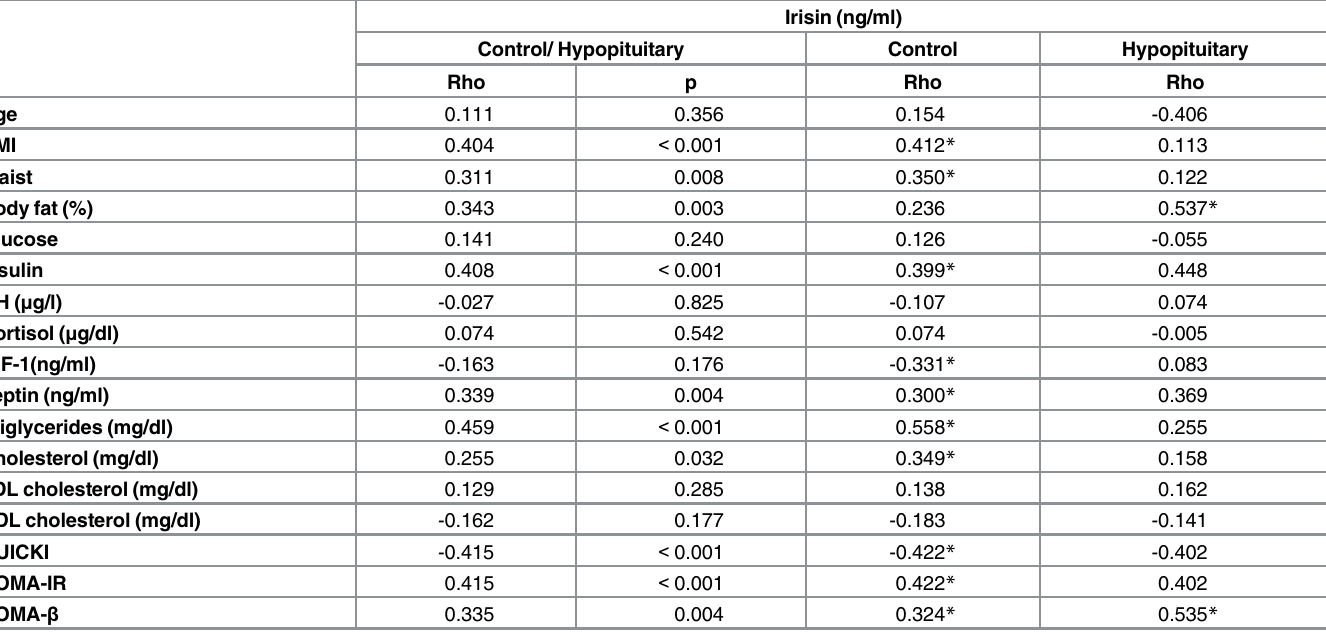
Table 3. Correlations between irisin and the different adiposity indices and hormonal data in the entire group of healthy controls and hypopituitary patients, and in the two individual